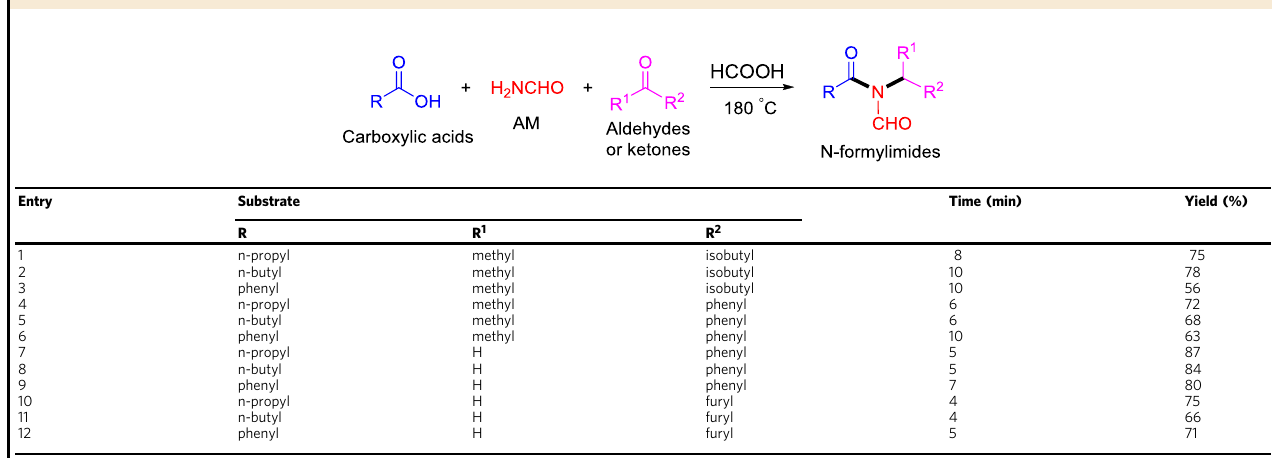
Table 4 Three-component synthesis of N-formylimides from carboxylic acids, AM, and